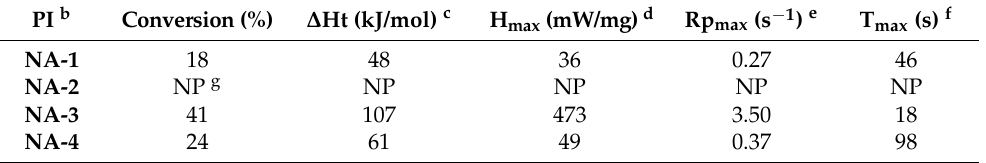
Table 3. Photo-DSC results based on LED@405 nm light irradiation a .